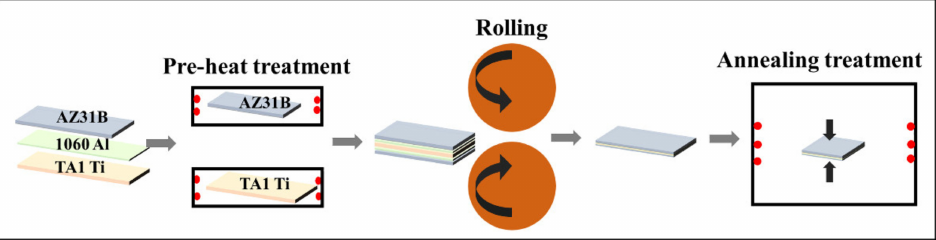
Figure 1. Schematic of differential temperature rolling process of Mg-(Al-)Ti